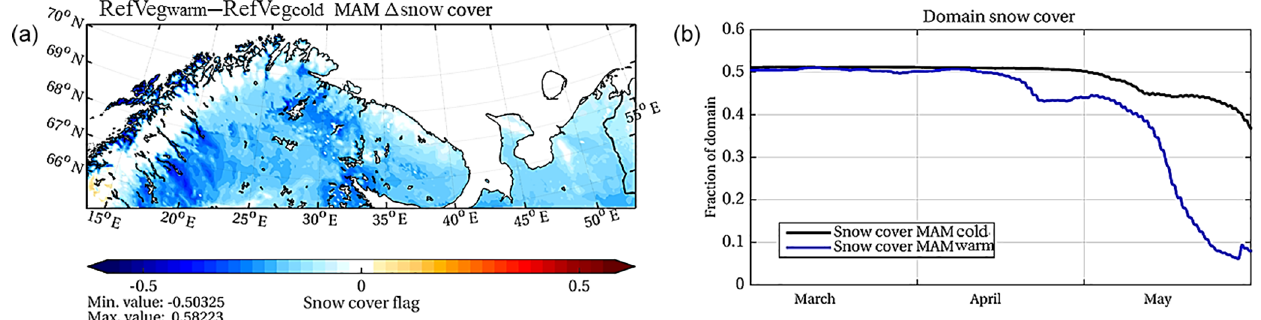
Figure 7. Difference in mean seasonal snow cover between the warm and cold spring seasons (RefVeg warm –RefVeg cold ) . Mean seasonal spatial differences are shown in panel (a) , and the temporal development over the seasons is shown in panel (b) .